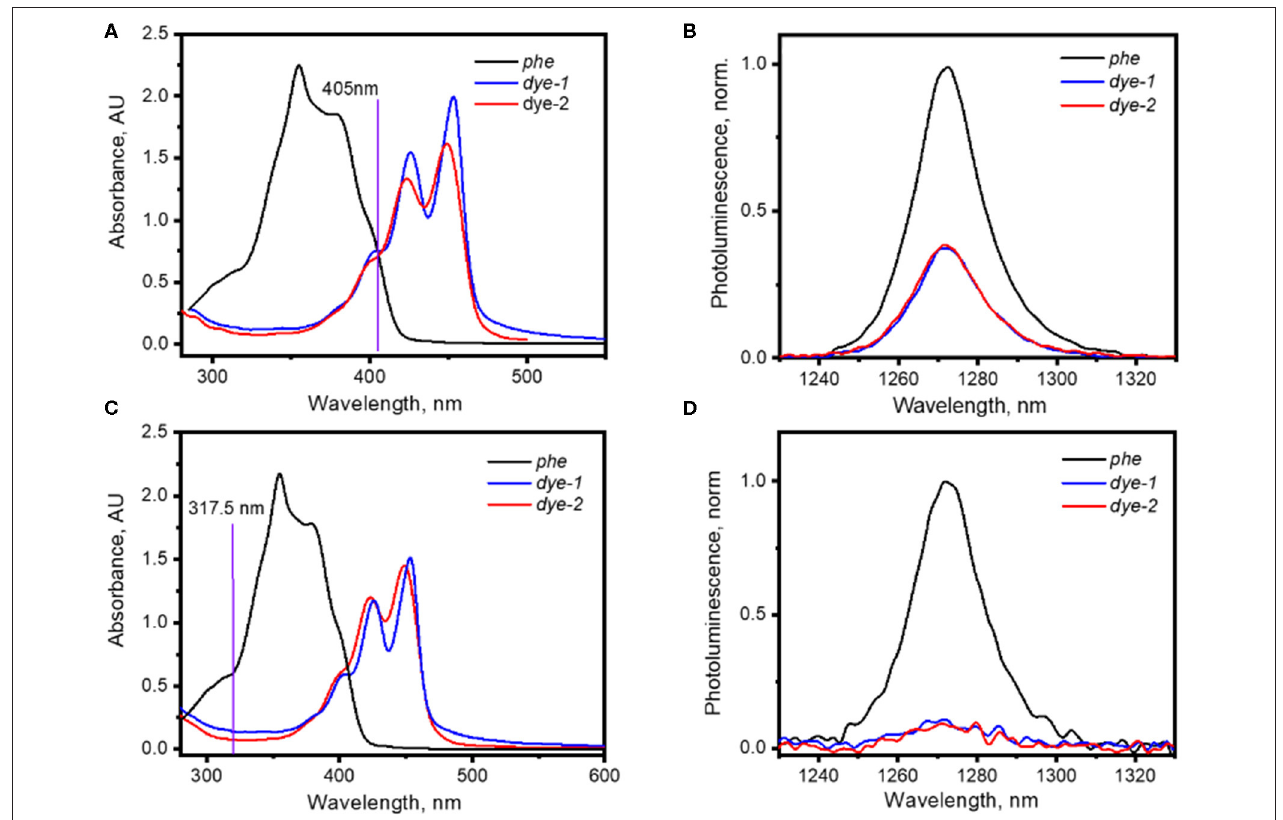
FIGURE 2 | (A) UV-Vis absorption spectra of solutions of phe , dye-1, and dye-2 in cyclohexane used for the generation of 1 O 2 with 405nm laser; (B) 1 O 2 phosphorescence excited via irradiation of solutions of phe and dye-1 with 405nm laser (75 mW); (C) UV-Vis absorption spectra of solutions of phe , dye-1, and dye-2 in cyclohexane used for the generation of 1 O 2 with 317.5nm laser; (D) 1 O 2 phosphorescence excited via irradiation of solutions of phe , dye-1, and dye-2 with 317.5nm laser (excitation intensity of 15 mW).